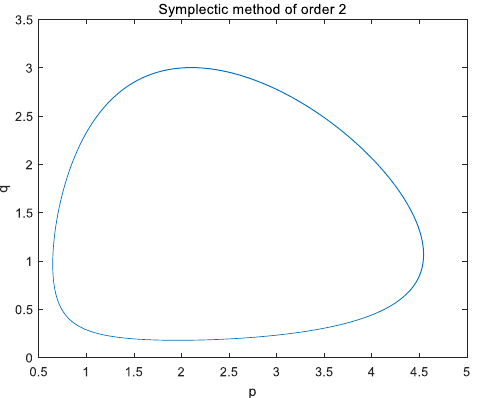
Figure 2. Trajectory of the non-canonical variable 𝑝,𝑞 .